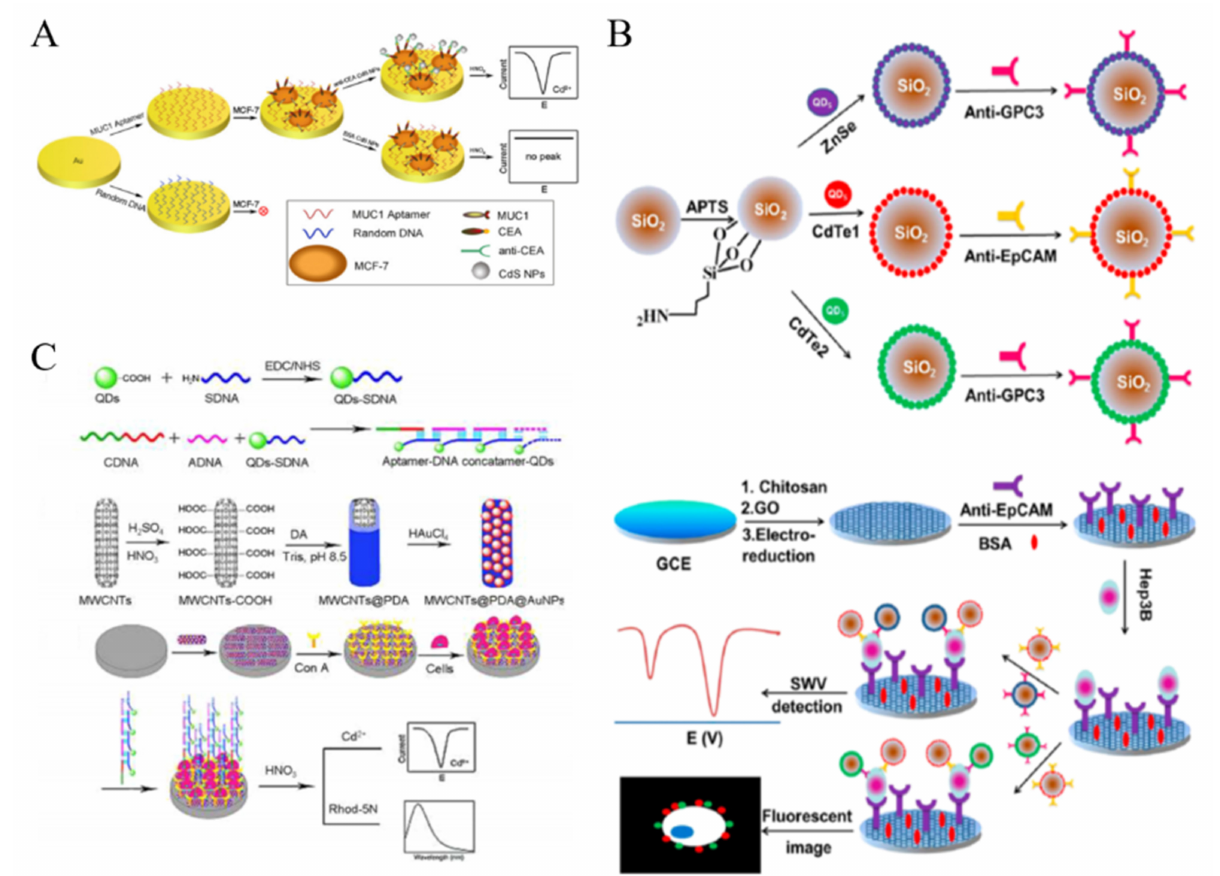
Figure 11. ( A ) Schematic representation of the method to detect breast cancer cells through simultaneous recognition of two different tumor markers [198]. Copyright 2010 Elsevier B.V. ( B ) Schematic representation of the preparation of antibody-modified QDs-loaded Si NPs and the detection procedure of CTCs [204]. Copyright 2013 American Chemical Society. ( C ) Schematic representation of the fabrication of aptamer-DNA concatamer-QDs and MWCNTs@PDA@AuNPs composites and super-sandwich cytosensor [206]. Copyright 2013 American Chemical